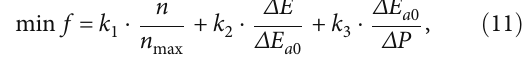
The projectile is loaded with target location information and